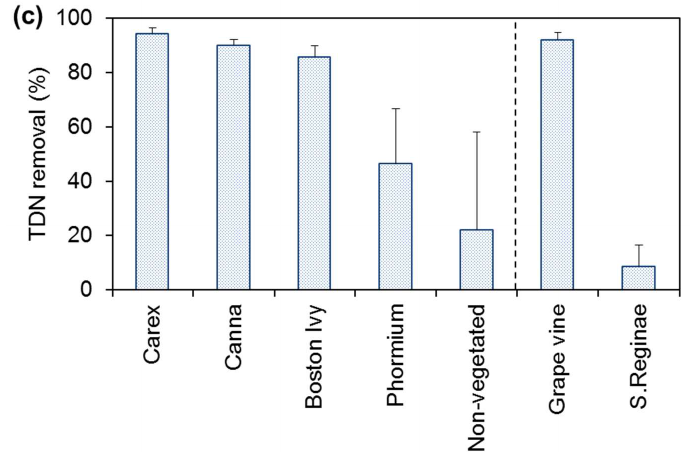
Figure 2. Performance of biofilter designs measured two weeks after 15 N testing in October 2015. ( a ) Nitrogen species concentration of influent and effluent water; ( b ) Proportion of each nitrogen species as a percentage of total nitrogen in effluent water across plant species; ( c ) Total dissolved nitrogen (TDN) removed by the different designs expressed as percentage of influent TDN [6].